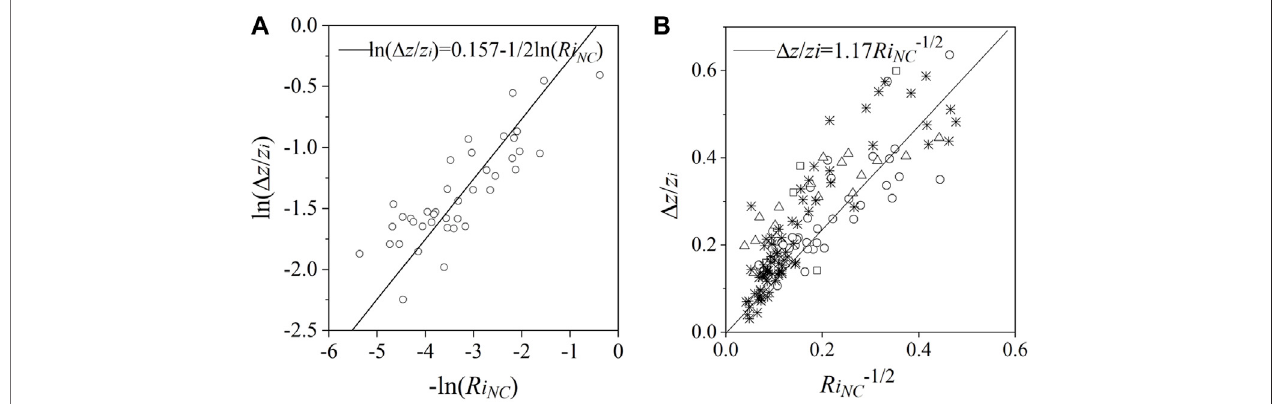
FIGURE 9 | Scaling relation between the dimensionless thickness of entrainment zone Δ z / z i and Ri NC . ○ experimental data of this study; ✳ radar data from Boers and Eloranta(1986); □ radar data from Lothon et al. (2008); △ largeeddy simulation data ofOtte and Wyngaard (2001); — linear fi t ofthe experimental data ofthis study.